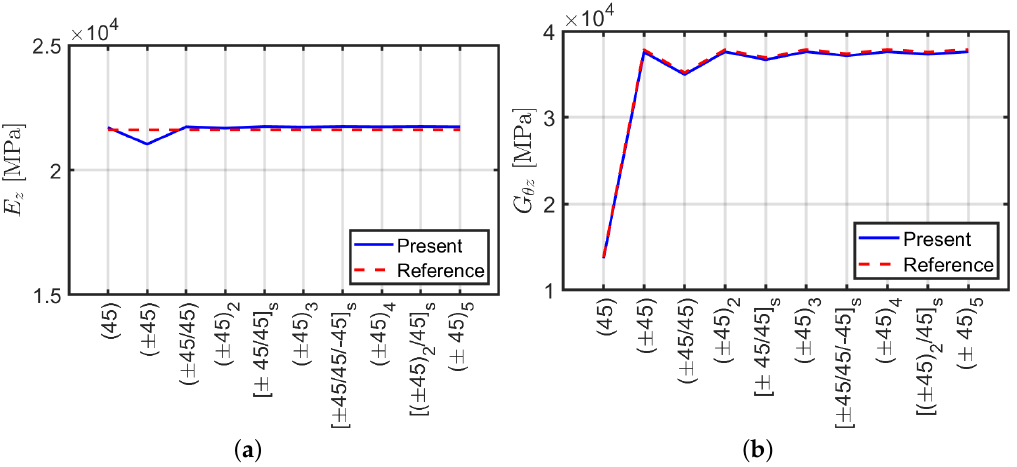
Figure 6. Equivalent moduli using ABAQUS and Sun et al. [40] approach: ( a ) normal E z ; ( b ) shear G θ z